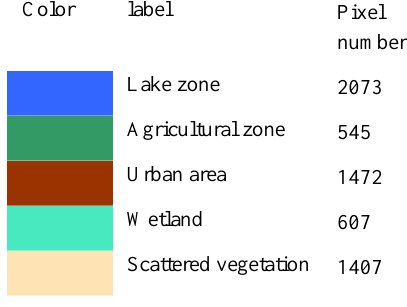
Figure 3. Study area